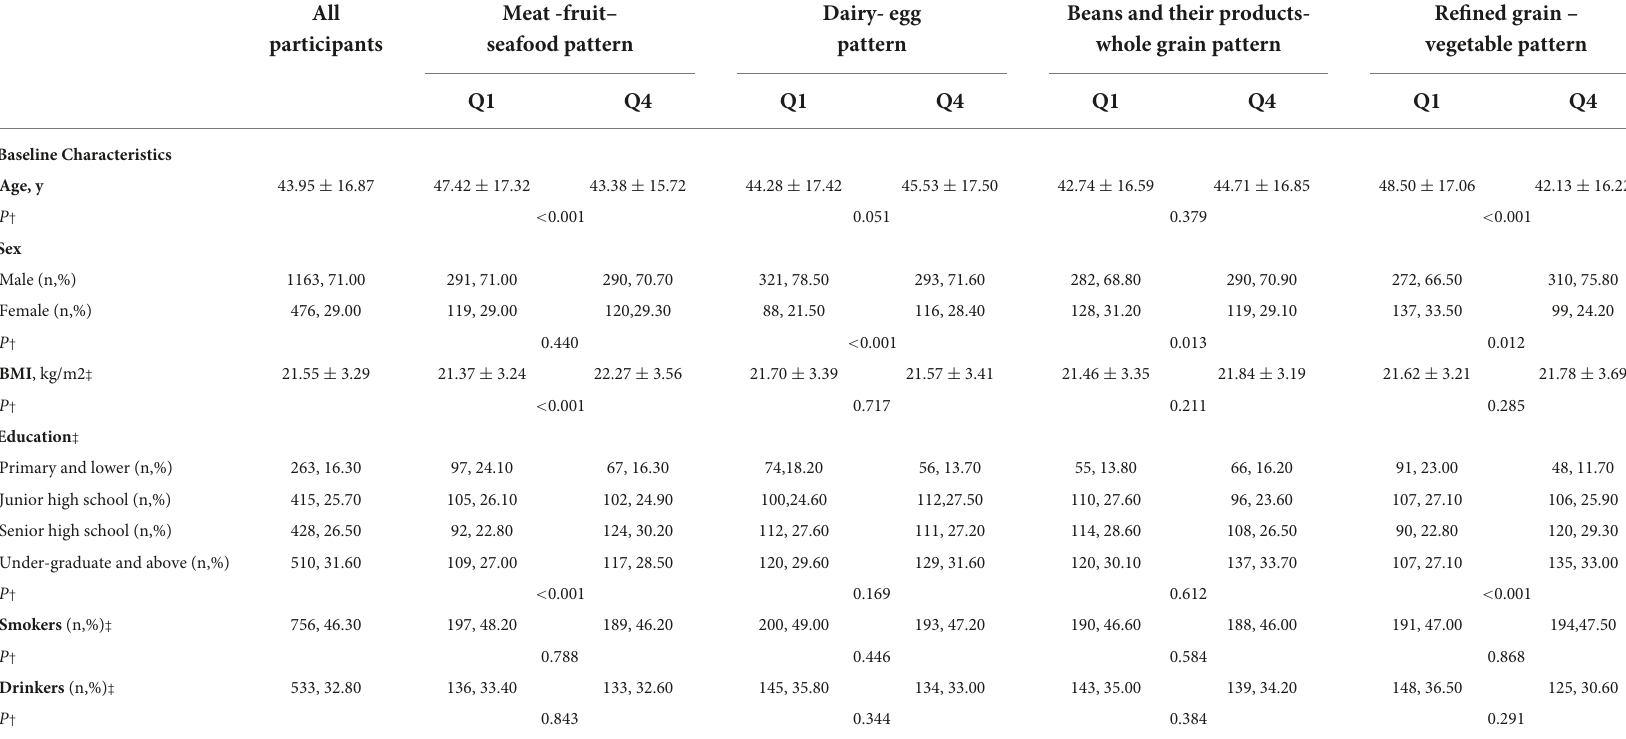
TABLE 2 Distributions of tuberculosis characteristics by dietary pattern score quartiles 1,639 patients with tuberculosis*. All Meat -fruit– Dairy- egg Beans and their products- Refined grain – participants seafood pattern pattern whole grain pattern vegetable